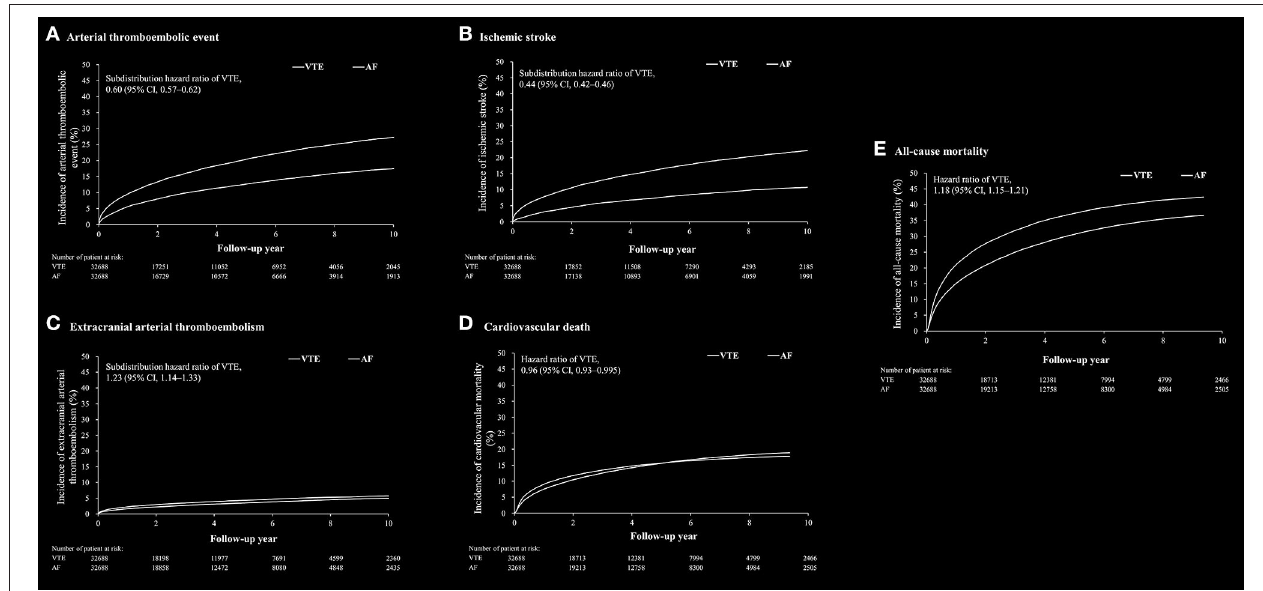
FIGURE 2 | The cumulative incidence rate of arterial thromboembolic event (A) , ischemic stroke (B) , extracranial arterial thromboembolic events (C) , cardiovascular death (D) and all-cause mortality (E) after propensity score matching between patients with venous thromboembolism (VTE) and patients with atrial